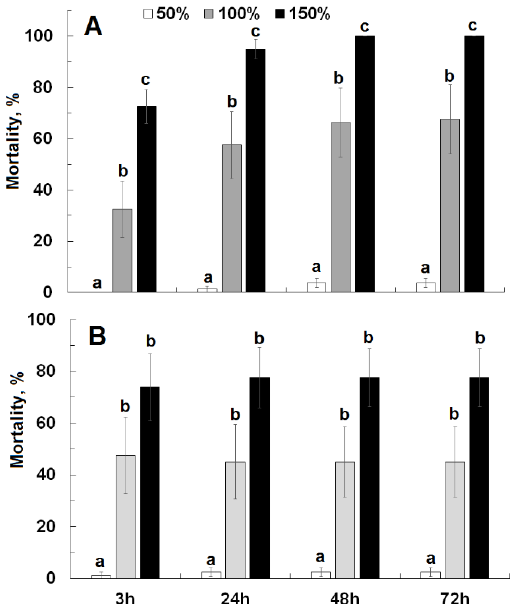
Figure 3. Cumulative effect of Civitas (( A ); 9.6 L/ha) and Silwet (( B ); 0.56 L/ha) applied at different moisture levels (50%, 100%, 150% filter paper saturation) on mortality of Listronotus maculicollis adults evaluated at 3, 24, 48 and 72 h after treatment. Means marked with the same letter do not differ statistically within each evaluation time.